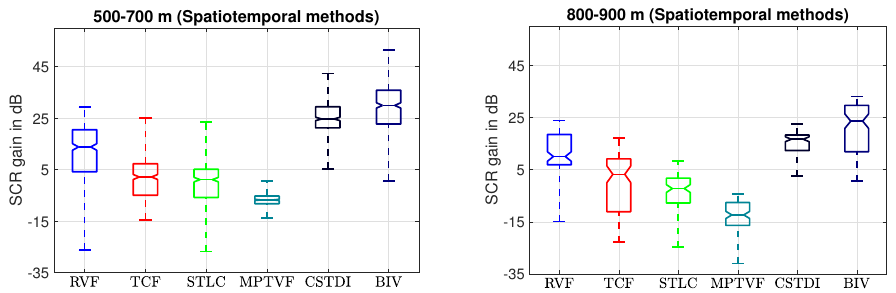
Figure 7. SCR gain distribution of the spatiotemporal detection methods. The BIV target detector provides the highest SCR gain compared to others.